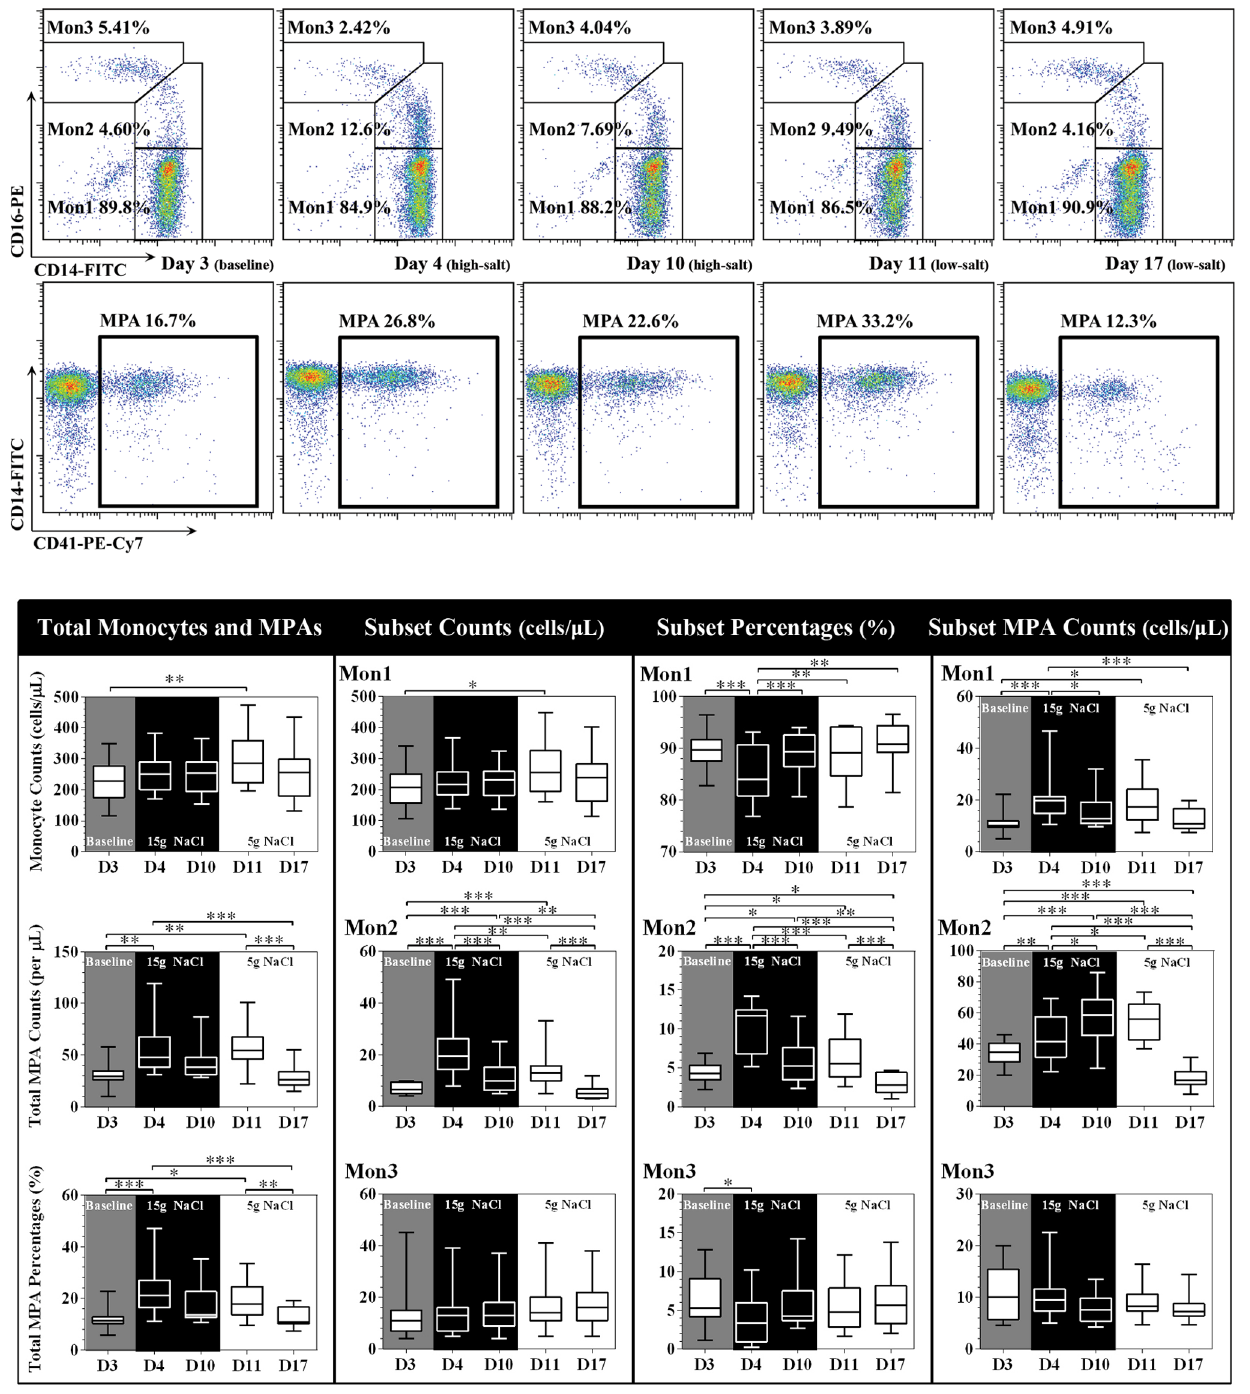
Figure 3. Representative flow cytometry analysis of monocyte subsets and MPAs from one participant and related statistical comparisons. Mon1 indicates CD14 ++ CD16 2 monocytes; Mon2 indicates CD14 ++ CD16 + monocytes; Mon3 indicates CD14 + CD16 ++ monocytes. The box and whisker plots: the boxes extend from the 25 th to the 75 th percentile, with a line at the median. The whiskers extend above and below the box to show the 5 th –95 th percentiles of values. ‘‘D3’’ to ‘‘D17’’ labeled in the x-axis indicates ‘‘day 3 0 to ‘‘day 17 0 . * P , 0.05, ** P , 0.01, *** P , 0.001 (one way repeated measures ANOVA or Friedman test, n=20). doi:10.1371/journal.pone.0060332.g003 median with interquartile range. To test the differences across Friedman test followed by a Dunn’s test for multiple comparisons time, a one-way repeated-measures ANOVA with Newman-Keuls were performed. Correlations between two continuous variables were calculated using Pearson’s or Spearman’s correlation post hoc analysis was used. If the data failed normality tests, a